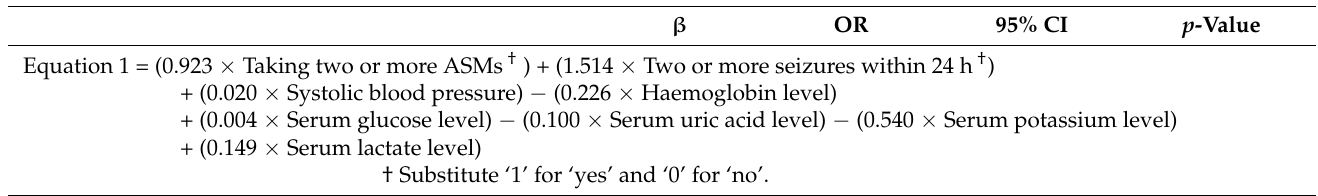
Model 2. Variable selection using LASSO